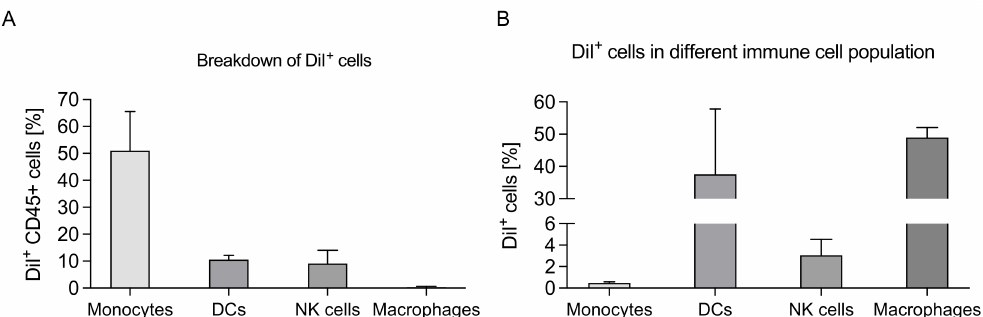
Figure 2. Delivery of DSTAP-liposomes to immune cells in the peritoneal cavity. ( A ) Percentage of total DiI+ cells by cell type (data = mean ± SD, n = 3). ( B ) DiI+ cell population in each cell type in the peritoneal cavity (data = mean ± SD, n =